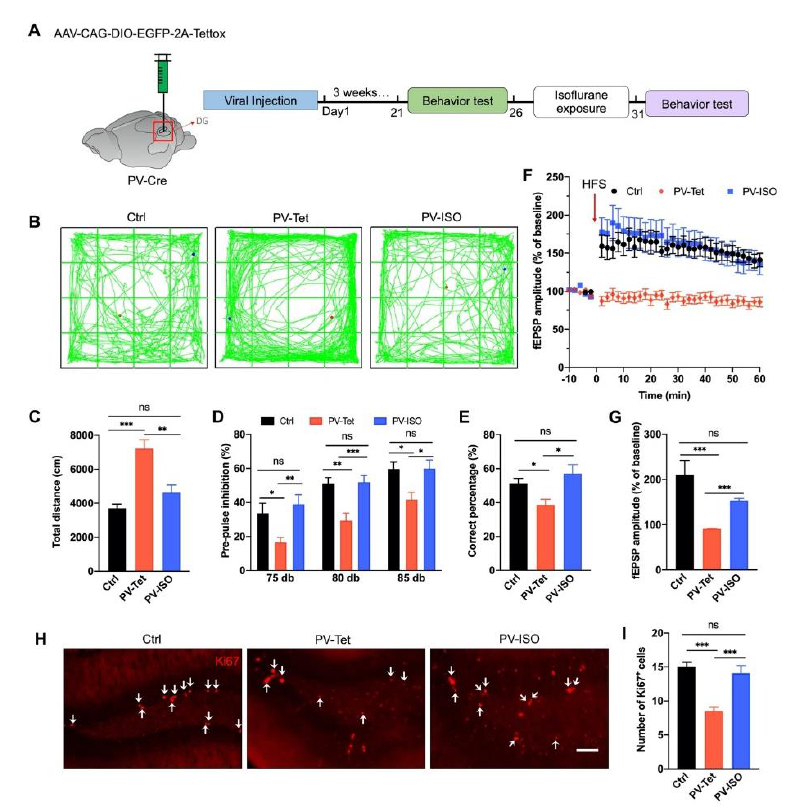
Figure 6. Isoflurane improves schizophrenia-related phenotypes induced by PV neuron’s GABA release inhibition in the DG. ( A ) AAV-CAG-DIO-EGFP-2A-Tettox was injected into the DG of PV-Cre mice to inhibit GABA release. ( B ) Representative traces of mice in the OFT. ( C ) Isoflurane treatment reversed the hyper-locomotion phenotype induced by PV neuron’s GABA release inhibition, revealed by OFT ( n = 8, 10, and 8 mice in control, PV-Tet, and PV-ISO groups, respectively. One-way ANOVA, F (2, 23) = 18.24, p < 0.0001; post hoc test: Ctrl vs. PV-Tet, p < 0.0001; PV-Tet vs. PV-Tet, p = 0.002; Ctrl vs. PV-ISO, p = 0.079). ( D ) Isoflurane attenuated the pre-pulse inhibition deficit induced by PV positive neuron’s GABA release inhibition ( n = 9, 10, and 10 mice in Ctrl, PV-Tet, and PV-ISO group, respectively). Two-way ANOVA, F (2, 72) = 2.873, p < 0.0001, post hoc test: Ctrl vs. PV-Tet, p = 0.01; PV-Tet vs. PV-ISO, p = 0.008; Ctrl vs. PV-ISO, p = 0.49). ( E ) The working memory deficit induced by PV neuron’s GABA release inhibition could be attenuated by isoflurane exposure ( n = 9, 10, and 10 mice in Ctrl, PV-Tet, and PV-ISO group, respectively. One-way ANOVA, F (2, 19) = 5.683, p = 0.01; post hoc test: Ctrl vs. PV-Tet, p = 0.01; PV-Tet vs. PV-ISO, p = 0.01; Ctrl vs. PV-ISO, p = 0.32). ( F ) Isoflurane reversed HFS induced LTP deficit induced by PV neuron’s GABA release inhibition ( n = 5 mice per group). ( G ) Quantitative analysis of data in ( F ). (Two-way ANOVA, F (2, 1155) = 713.5, p = 0.0002; post hoc test: Ctrl vs. PV-Tet, p = 0.0007; PV-Tet vs. PV-ISO, p < 0.0001; Ctrl vs. PV-ISO, p = 0.11). ( H ) Representative photomicrographs showing Ki67-positive cells in the DG. White arrowheads indicate target cells. Scale bar, 100 µ m. ( I ) Quantification data of ( H ). Five mice in each group, and five sections were picked and counted in each mouse. One-way ANOVA, F (2, 24) = 23.59, p < 0.0001; post hoc test: Ctrl vs. PV-Tet, p < 0.0001; PV-Tet vs. PV-ISO, p < 0.0001; Ctrl vs. PV-ISO, p = 0.5034. Data are